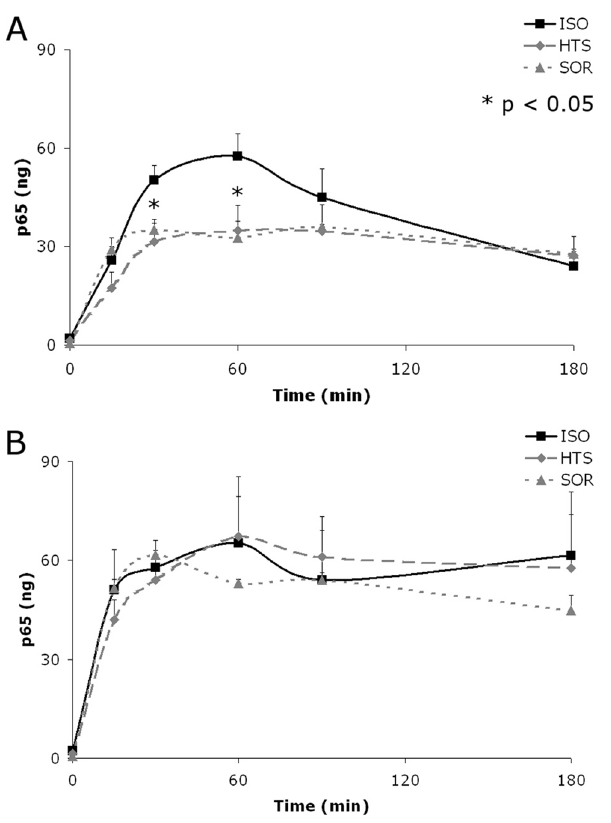
Figure 4. HOsm inhibits NF- k B activation by TNF a but not IL-1 b stimulation. The time course of NF- k B consensus binding of the p65 subunit in nuclear fraction of cells stimulated by TNF a (A) or IL-1 b (B) in the presence of 400 mOsm HTS or SOR (n 5 5). Activation assayed by DNA binding to consensus sequence; * p , 0.05 between ISO and HTS or SOR groups at matched time points; no significant differences were found between HTS and SOR